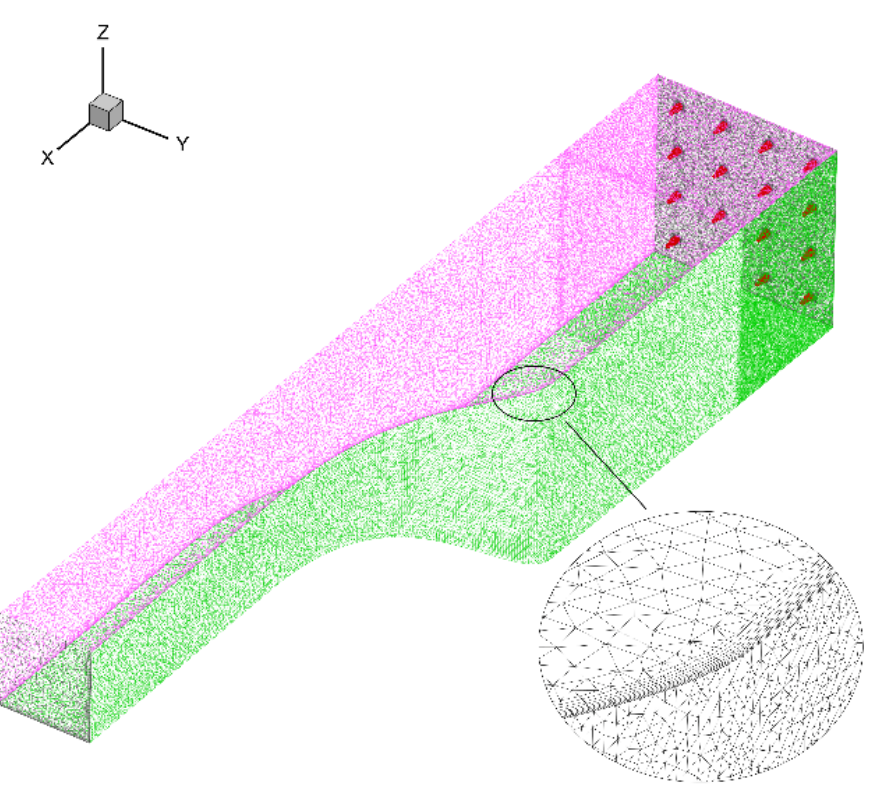
Figure 9. Mesh model and its wall details.